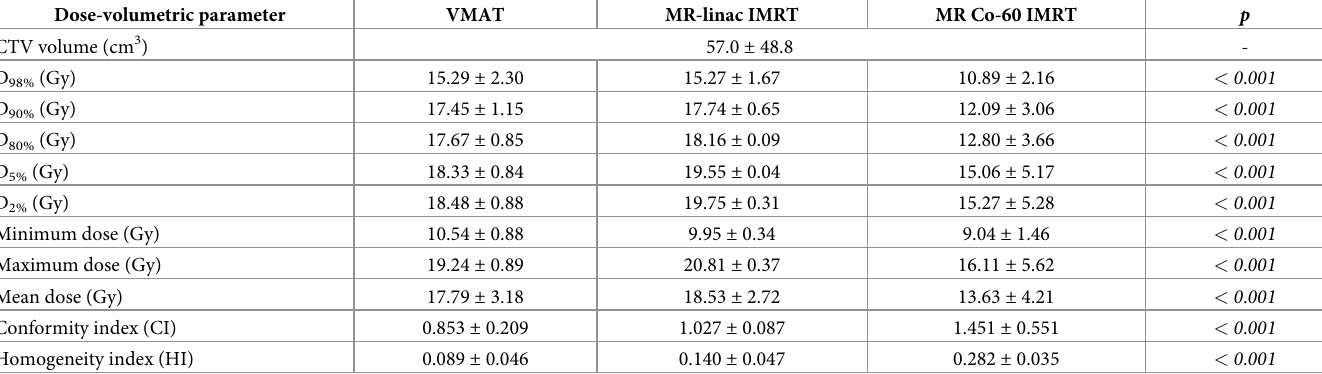
Table 3 presents the average dose-volumetric parameters of the spinal cord, spinal cord PRV, and whole body of each type of plans. The average volume of the spinal cord delineated with Table 2. Average dose-volumetric parameters of the clinical target volume (CTV) of VMAT, MR-linac IMRT, and MR-Co-60 IMRT plans. Dose-volumetric